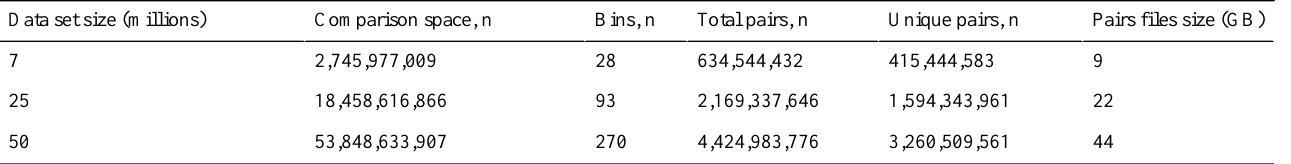
Table 3. Comparison space and pairs created during classification.